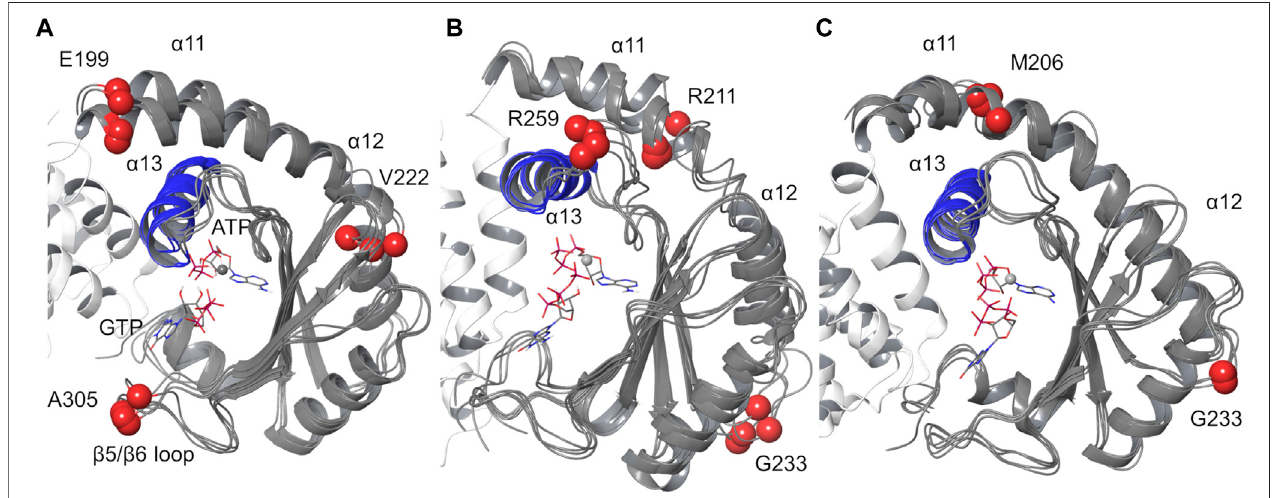
FIGURE 8 | Protein cluster analysis results for the SYNTH domain. C α atom of residues 197 – 334 are shown. (A) replica #1, (B) replica #2, (C) replica #3. The representative structures of the main clusters are superimposed to the most populated cluster. RMSD values calculated relative to the most populated cluster c1 < 2 Å ( Supplementary Table 3 ). Blue: helix α 13; red spheres: C α atoms of residues with higher RMSD